Question: What visual encoding does this figure use to show its data?
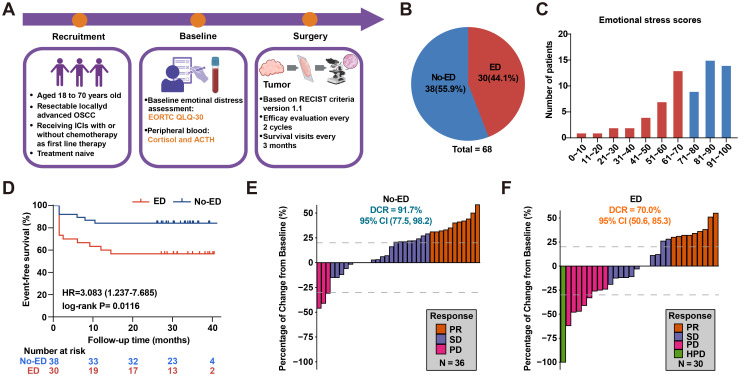
Answer: survival